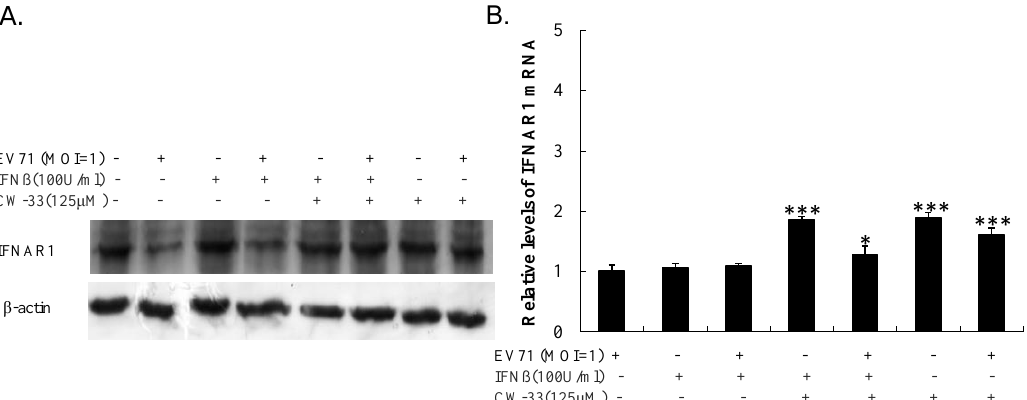
Figure 10. Recovery of IFNAR1 protein levels in EV-A71-infected cells by combined treatment of CW-33 and IFN-β. For analyzing protein levels of IFNAR1 ( A ), lysates of infected cells treated with or without CW-33, IFN-β, or combination were separated by 10% SDS-PAGE and transferred onto nitrocellulose paper. Blot was probed with specific mAb against IFNAR1, developed with enhanced chemiluminescence substrates. Cells were harvested for measuring IFNAR1 mRNA expression using Real-time RT-PCR36 h post-infection and treatment ( B ). * p value < 0.05; *** p value < 0.001 by Scheffe test.